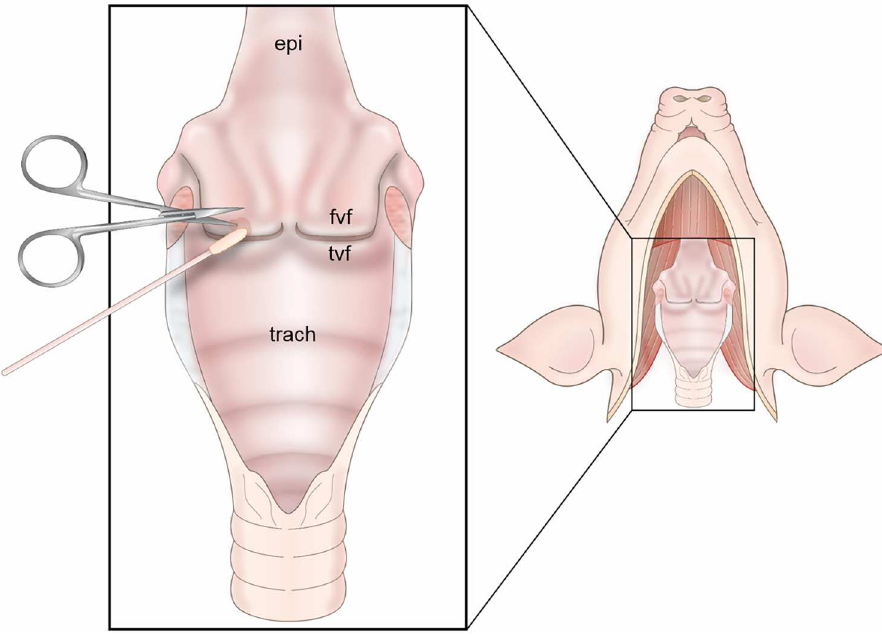
Fig 1. Schematic depicts the relative location of true (tvf) and false (fvf) vocal folds within the pig, with the epiglottis (epi) located closer to the mouth, and the trachea(trach) located posterior to the vocal folds. Swabs and biopsiedtissue samples were taken from both true and false vocal folds on both left and right sides.